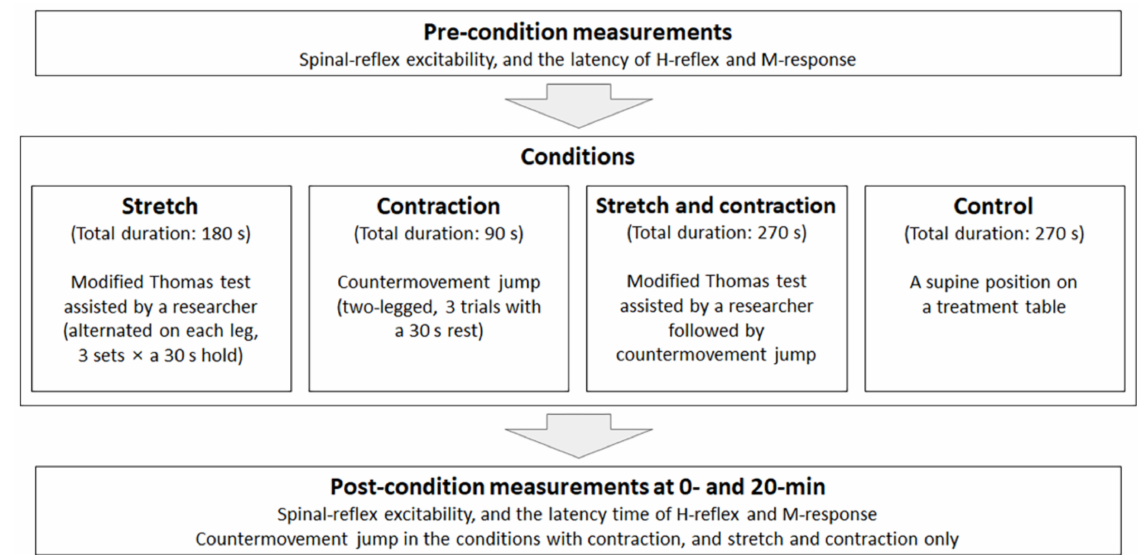
Figure 1. Testing procedures. Countermovement jumps were performed in the conditions with contraction (contraction, and stretch and contraction) during the conditions ( × 3), and post-condition at 0 ( × 3) and 20 min ( × 3).